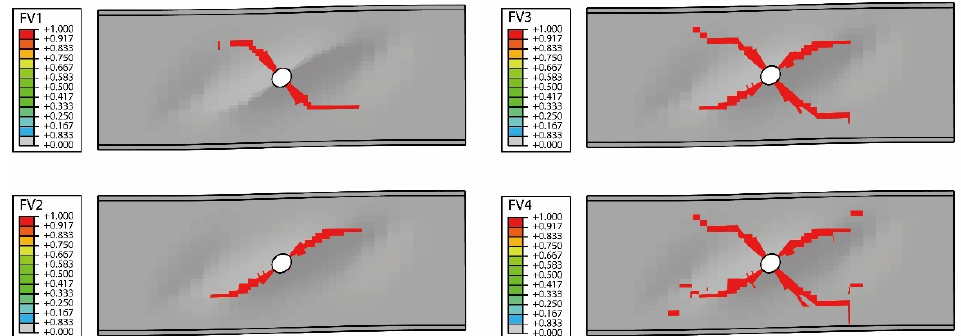
Figure 33. The calculate damage states of the surface ply in the composite beam of BW-II after the final collapse under shear load. final collapse under shear